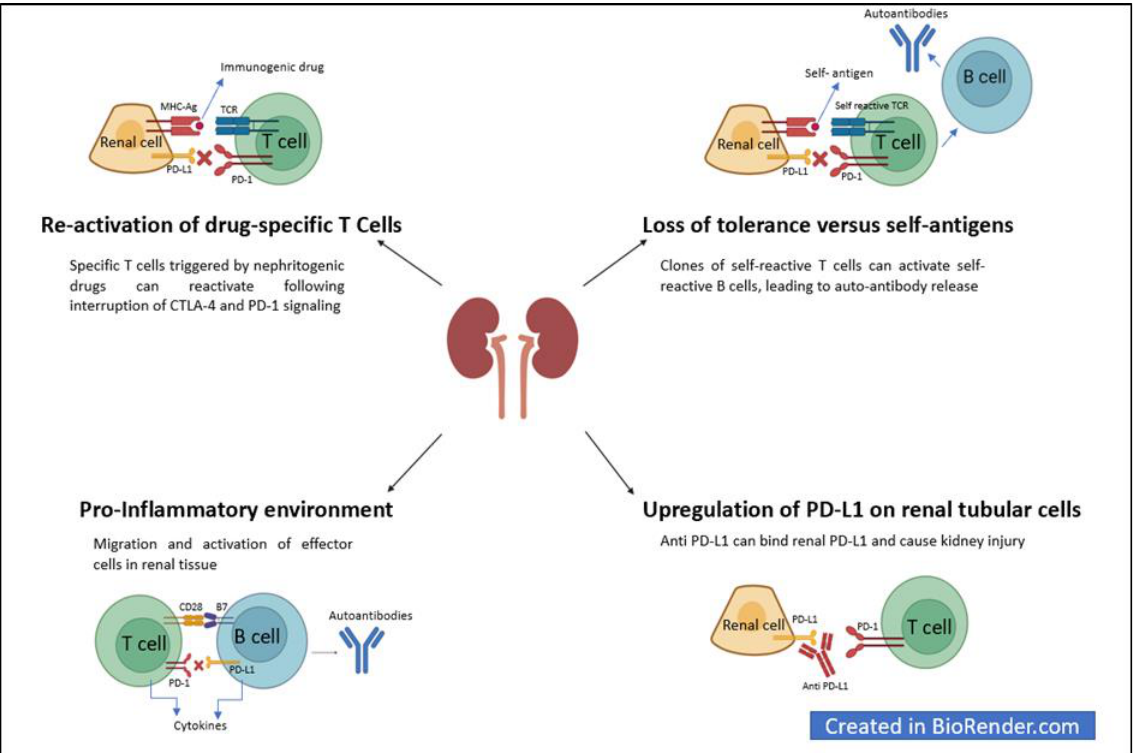
Figure 2. Mechanisms of kidney damage from ICLs. Legend: APC, antigen-presenting cell; B7, B7 molecules; CD28, cluster of differentiation 28; CTLA-4, cytotoxic T-lymphocyte antigen-4; MHC, major histocompatibility complex; PD-1, programmed death protein 1; PD-L1, programmed death ligand 1; PD-L2, programmed death ligand 2; TCR, T-cell receptor.